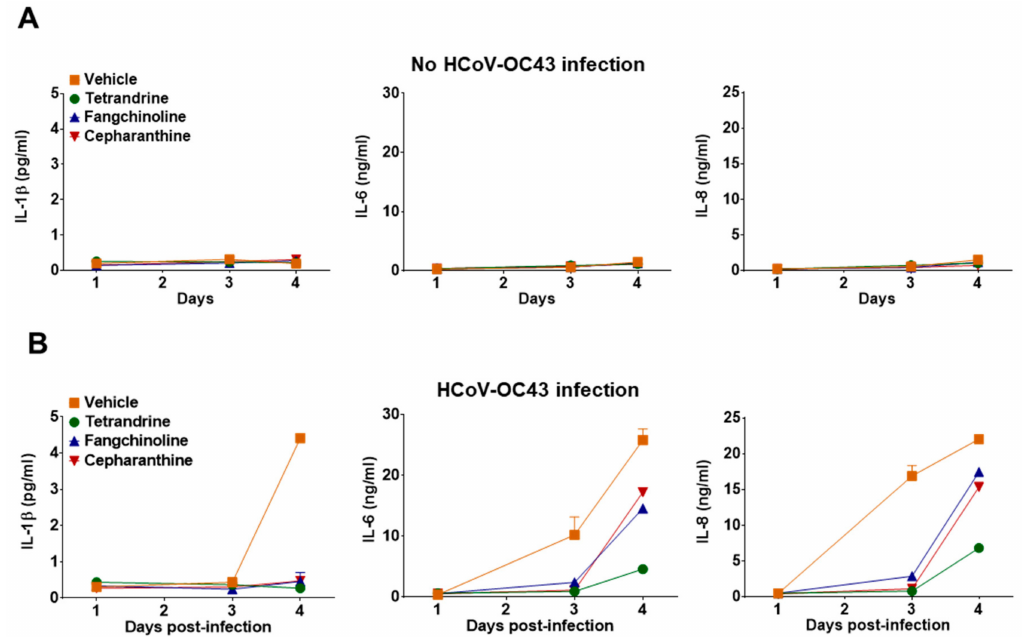
Figure 7. Reduced inflammatory cytokine production by treatment with TET, FAN, and CEP in HCoV-OC43-infected MRC-5 cells. ( A and B ) MRC-5 cells with or without HCoV-OC43 infection were treated with vehicle (0.025% DMSO), or the compounds (5 µ M). The secretion of inflammatory cytokines IL-1 β , IL-6, and IL-8 was quantified by CBA in the compound-treated virus-uninfected supernatant ( A ) and the compound-treated virus-infected supernatant ( B ) at 1, 3, and 4 dpi. Data are presented as means ± SEM of three independent